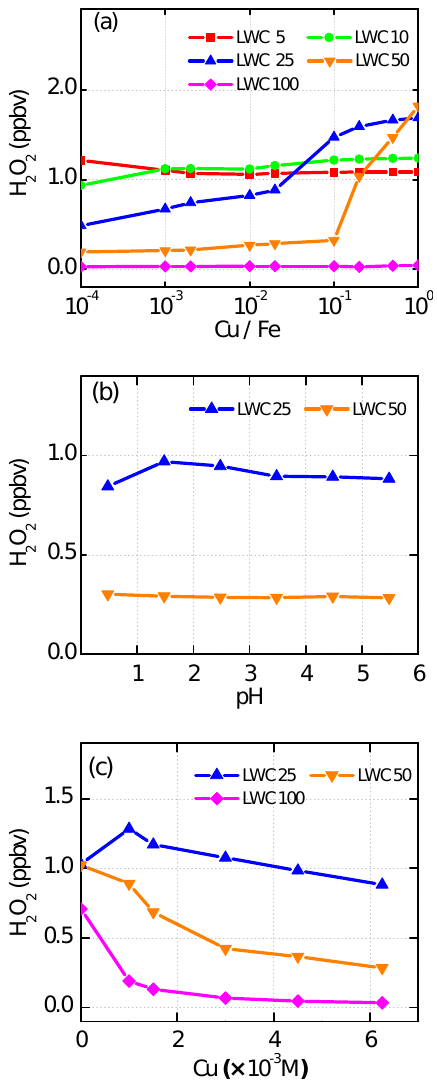
Fig. 8. Impacts of aerosol aqueous phase Cu/Fe, pH, and Cu con- centration on gaseous H 2 O 2 concentrations at different LWC levels (µgm − 3 ) . (a) – (b) Cu concentration is held fixed at 6.25 × 10 − 3 M. (b) – (c) Cu/Fe is held fixed at 0.02.